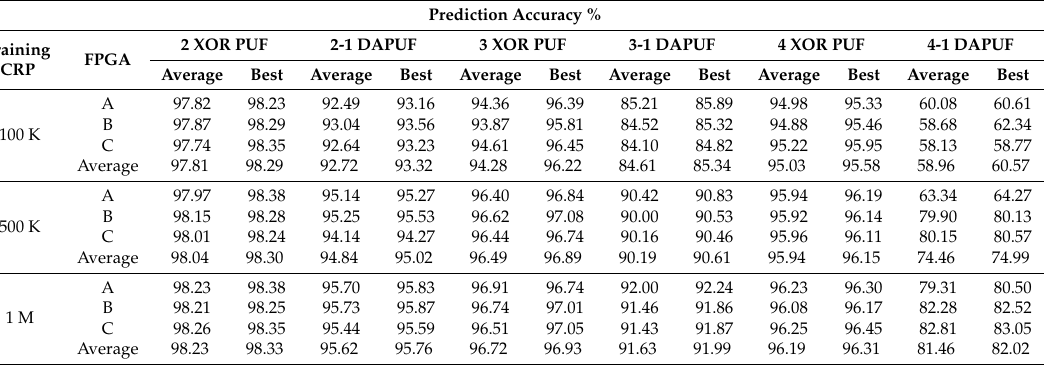
Table 4. Modeling accuracy results for DAPUF